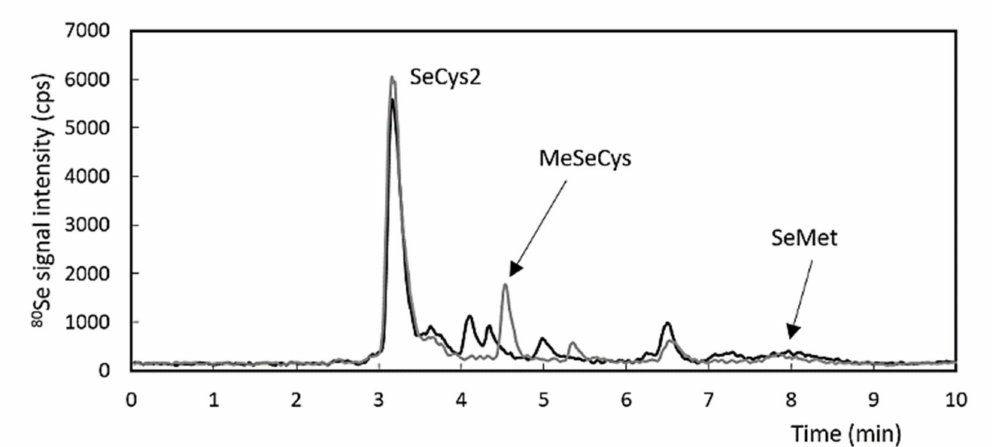
Figure 3. Chromatogram of the liver extract (black) and kidney extract (grey); both organ types were collected from group D rats (Altromin C 1045 + Se-enriched Streptococcus thermophilus (SeST)).